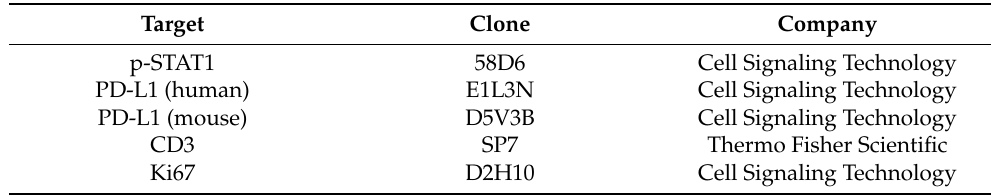
Table 1. Antibodies used for